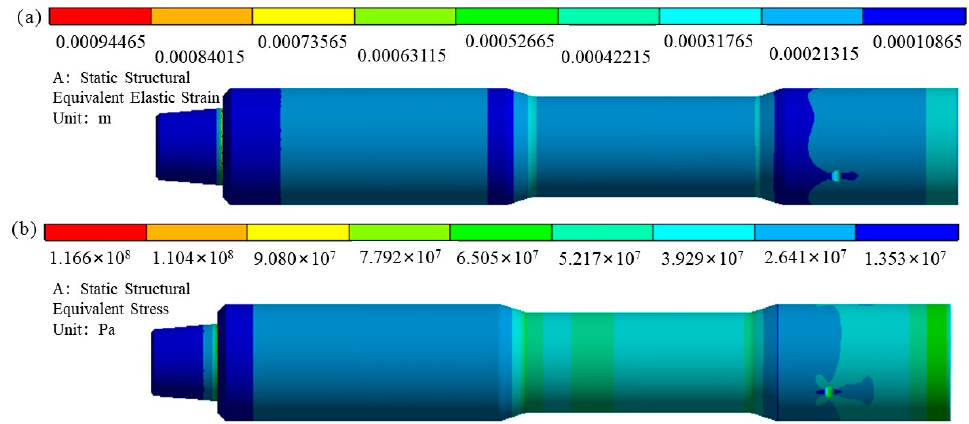
Figure 5. Deformation and stress diagram of downhole solid–liquid separator. ( a ) Deformation distribution; ( b ) stress